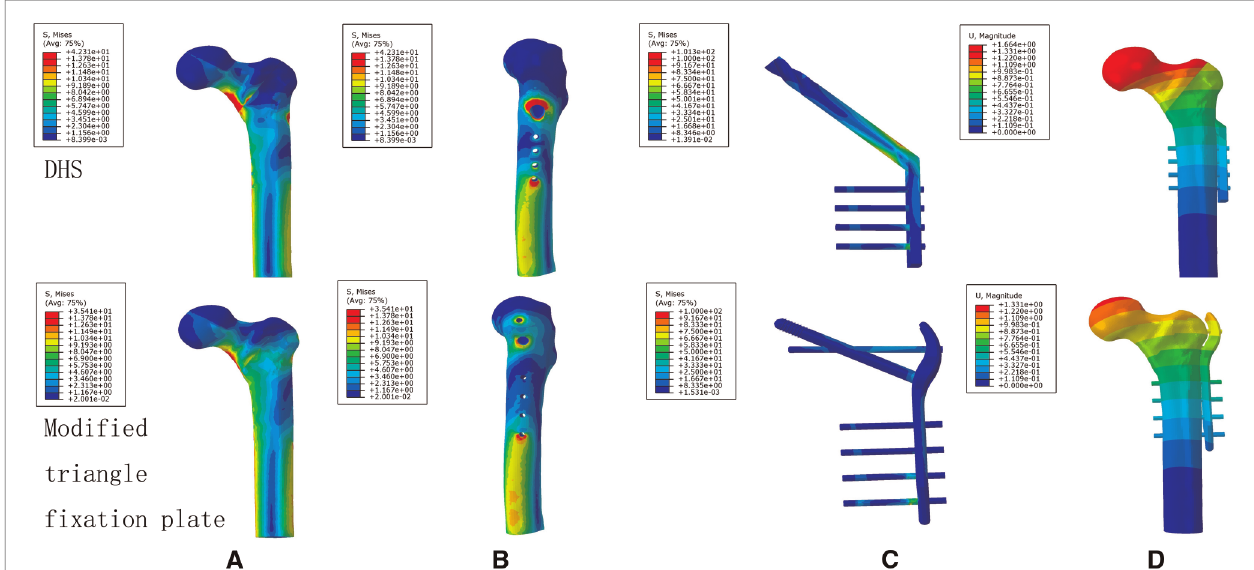
FIGURE 8 | The stress distribution and displacement distribution of two implant fi xations of a stable intertrochanteric fracture; ( A ) the stress distribution of bone models; ( B ) the stress distribution of the lateral femoral cortex; ( C ) the stress distribution of an implant model; ( D ) the displacement distribution of three implant fi xation models. The fi gure shows that the TSFP has improved the stress distribution of the implant and bone models and increased the construct stability of the fi xation of Evans type I intertrochanteric fracture.